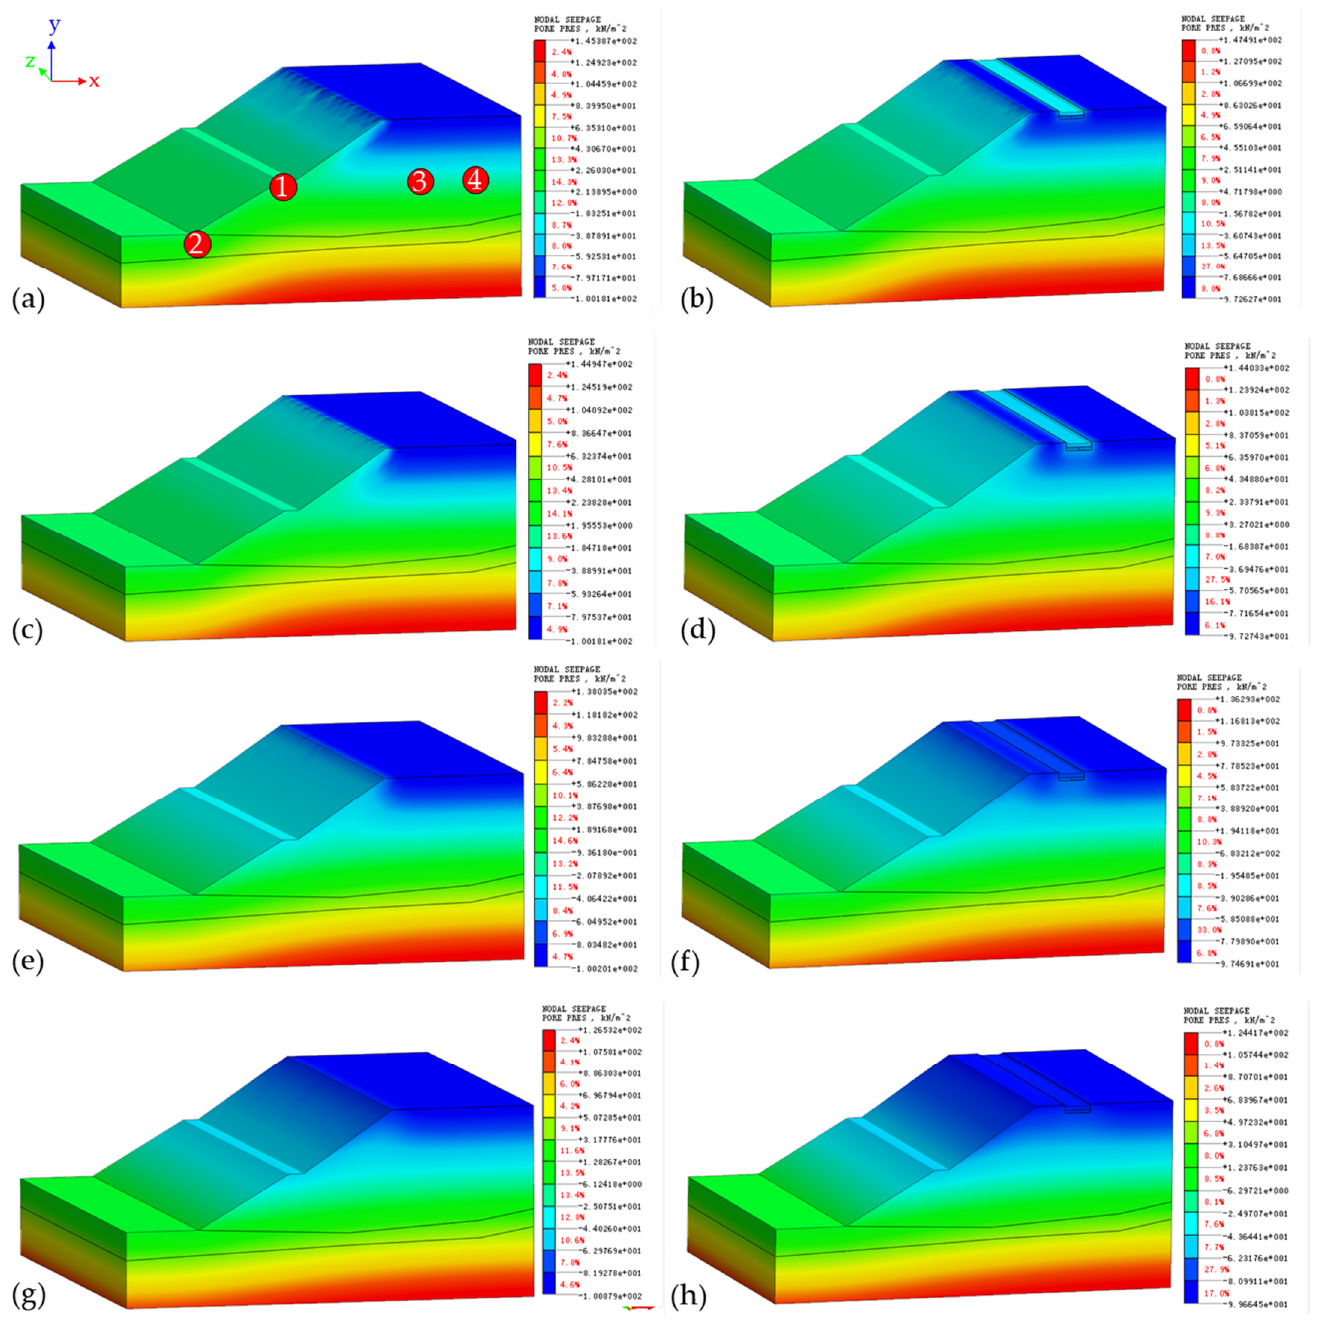
Figure 5. Comparison of water pressure distribution on subgrade slopes without or with biological retention facilities within 48 h after rainfall: ( a , b ) 6 h; ( c , d ) 12 h; ( e , f ) 24 h; ( g , h ) 48 h.